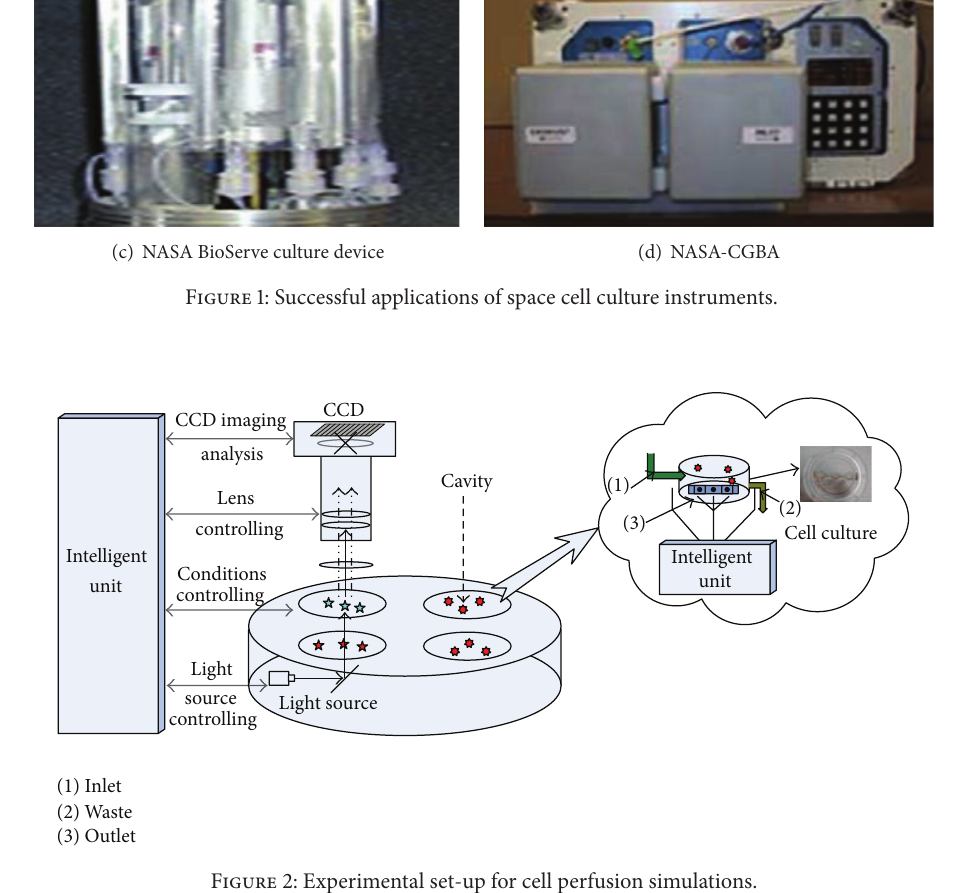
Figure 2: Experimental set-up for cell perfusion